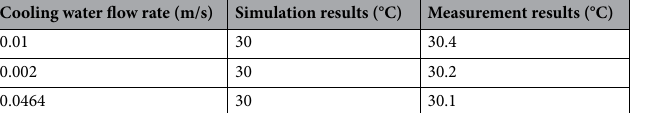
Table 4. Comparison of simulation results and experimental results at different cooling water flow